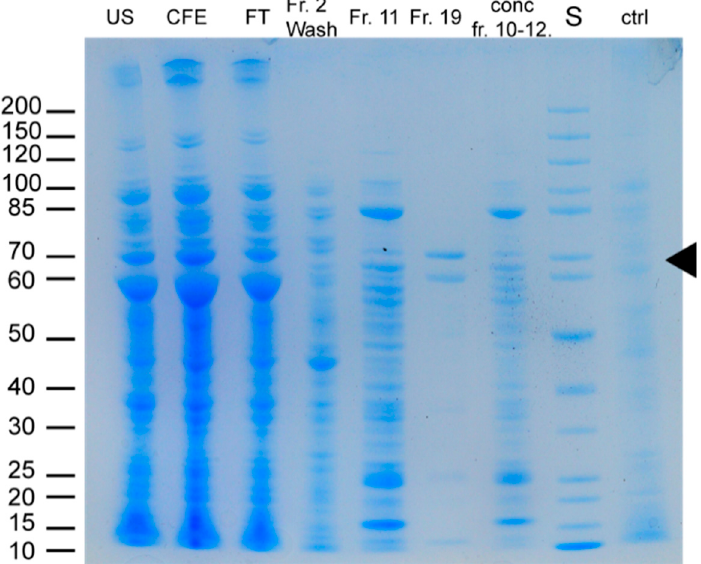
Figure 5. SDS-PAGE analysis of the chromatographic isolation of VPO-RR using an Ni-column. Chaperone (implemented in E. coli ArcticExpress (DE3) (Agilent Technologies)) size of Cpn60: ~60 kDa; Cpn10: ~10 kDa. US: cell debris after ultrasonication; CFE: cell-free extract; FT: flow-through of Ni-NTA column; Fr.: fractions collected during Ni-NTA isolation; conc.: concentrated fractions after pooling; S: Standard; ctrl: empty-vector control of E. coli ArcticExpress